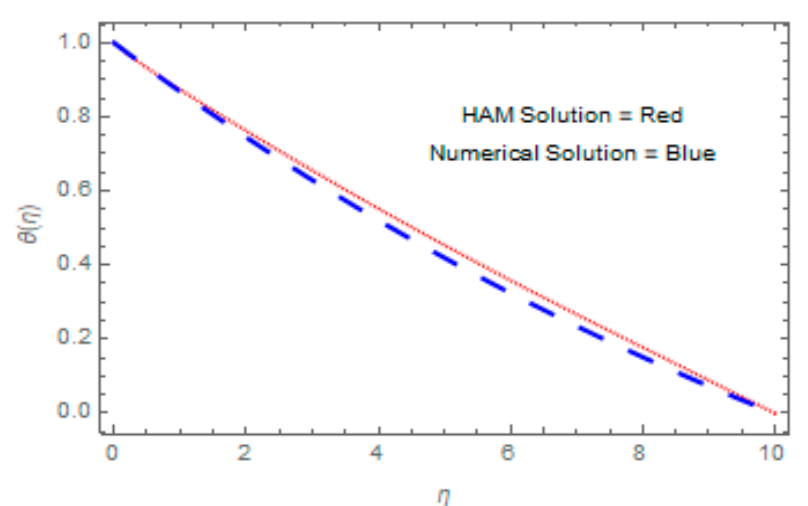
Processes 2020 , 8 , x FOR PEER REVIEW Figure 13. Nu for dissimilar values of (cid:1844)(cid:1856) . Figure 13. Nu for dissimilar values of Rd